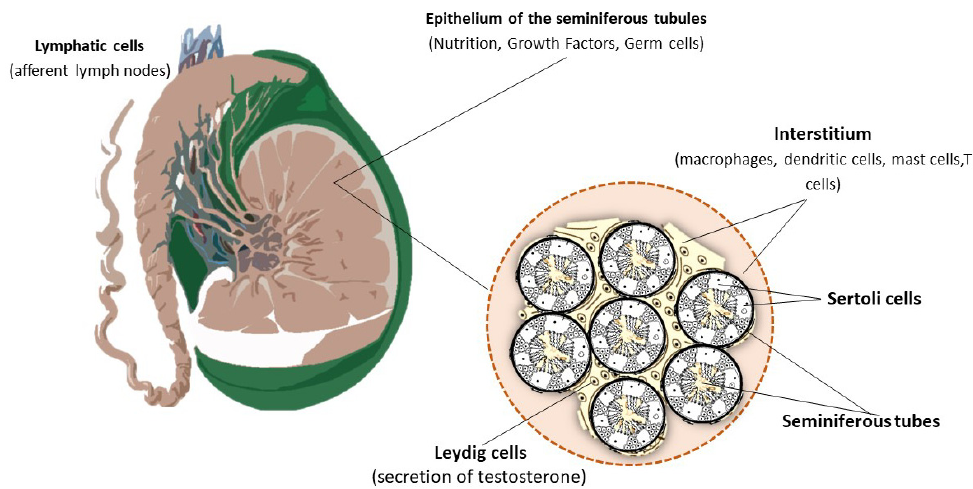
Figure 1. Structure of the testis. The structure of the testis consists of the epithelium of the seminiferous tubules and the intestitium. In turn, the interstium harbors Leydig cells, immune cells and lymphatic vessels.